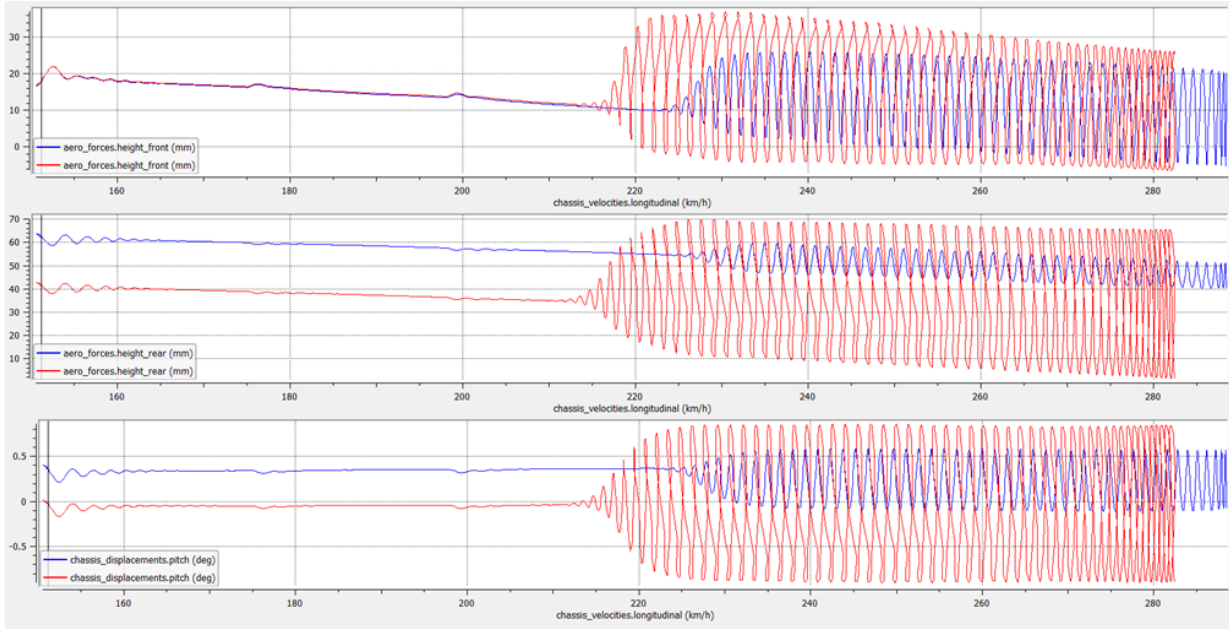
Figure 24. Front ride height +10 mm (blue): porpoising is partially mitigated mainly because bouncing is reduced at the front end in terms of amplitude. In this plot FRH ( top ), RRH ( center ) and pitch variation ( bottom ) are shown.